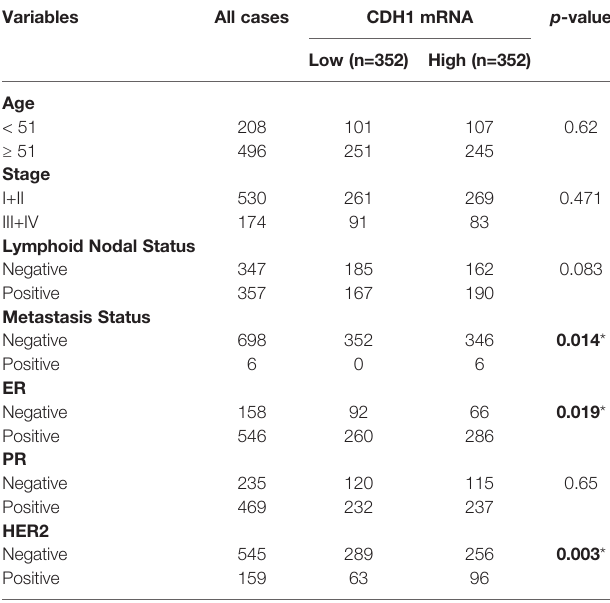
TABLE 1 | Correlations between CDH1 expression in tissue and clinicopathological parameters of BC patients.